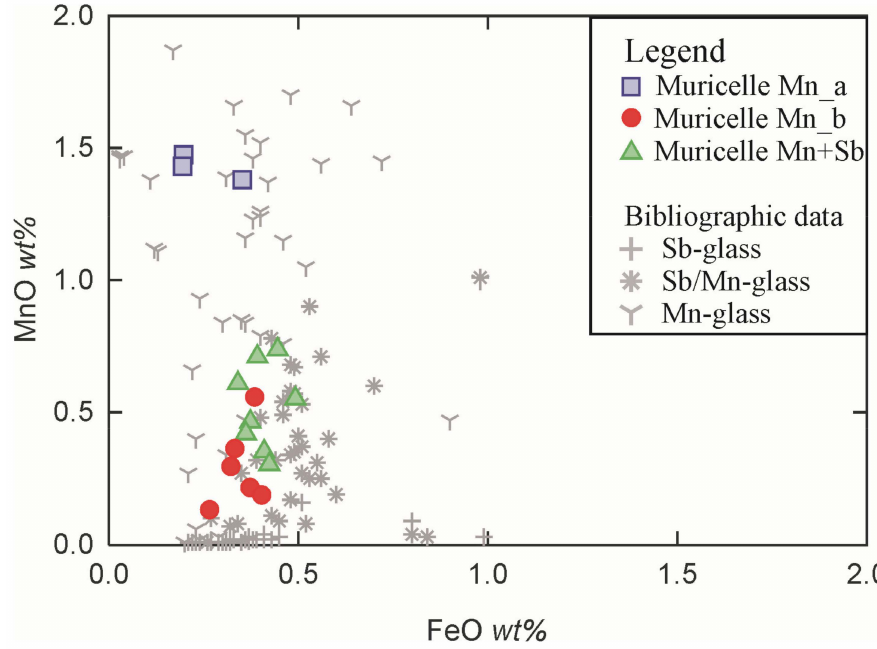
Figure 5. FeO versus MnO diagram. The bibliographic data refer to coeval Roman glasses [5,8,15,17,34]. In all samples of Mn_b and Sb + Mn groups and in the M15 sample of Mn_a group, CuO and/or PbO and/or SnO were detected in amounts higher than 100 ppm; this also suggested the production through recycling involving coloured glass scraps added in the re-melting process